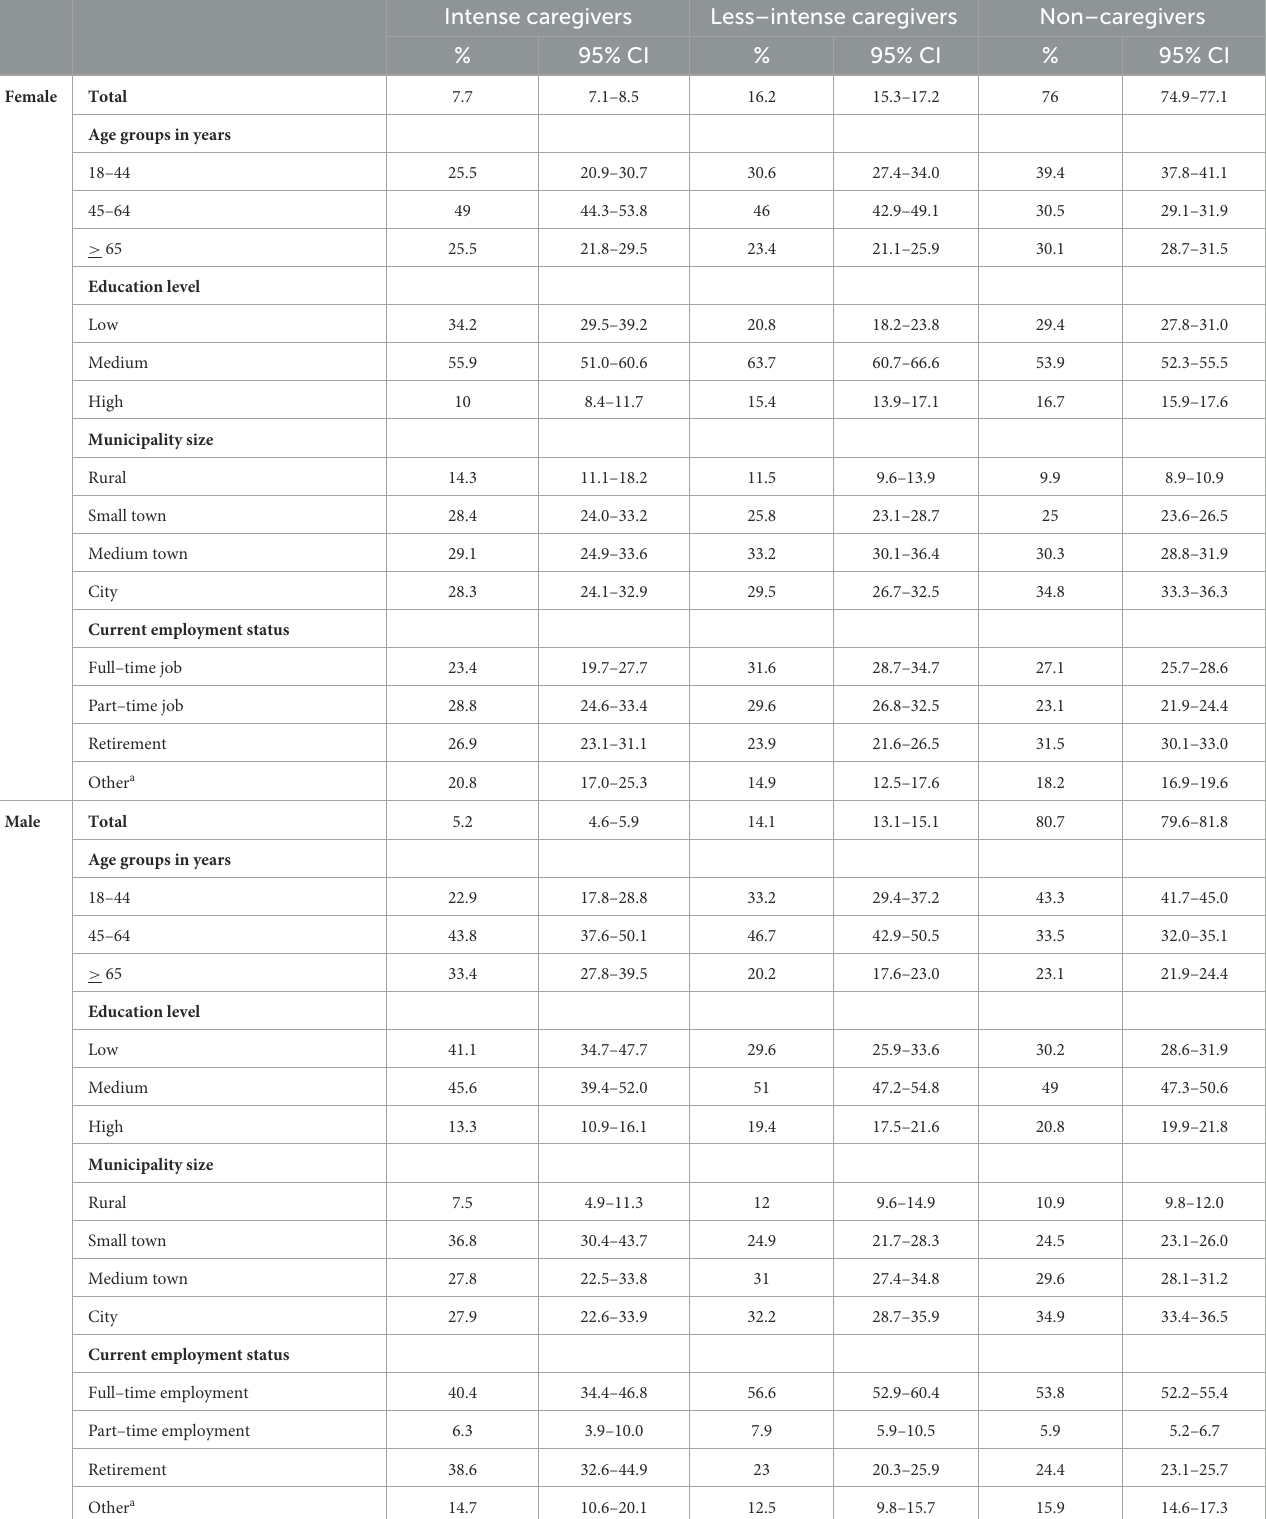
TABLE 2 Social characteristics by provision of informal care (weighted